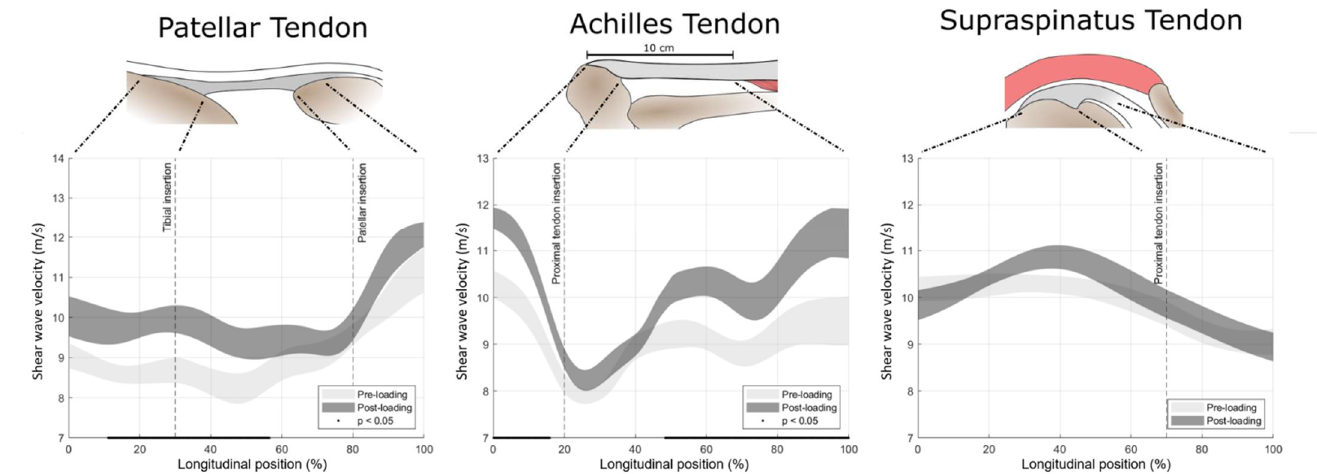
Figure 6. Top row: schematic representation of the assessed structures with the anatomical landmarks used for spatial referencing. Bottom row: areas of uncertainty around the estimate of the mean (±SE) shear wave velocity before and after 15 s maximum voluntary isometric tendon loading over the longitudinal axis of the tendon. Longitudinal positions with a statistically significant load response are underlined with a black line.